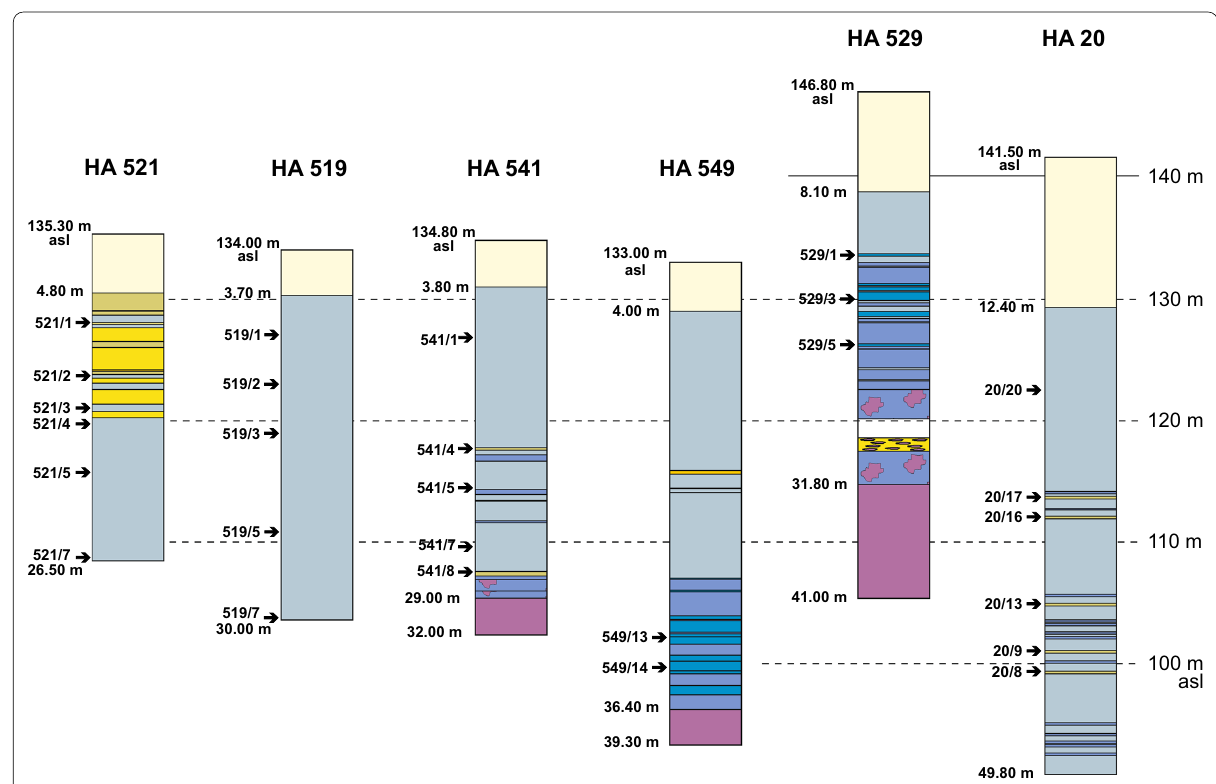
Fig. 5 Lithologs of cores studied only for ostracodes. The logs are arranged according to their position in respect to altitude (asl) and roughly perpendicular to the axis of the Mesozoic ridge. Indicated for all drillings are sample locations (arrow), altitude asl, depth of the Quaternary, depth of Mesozoic basement (if reached) and the final